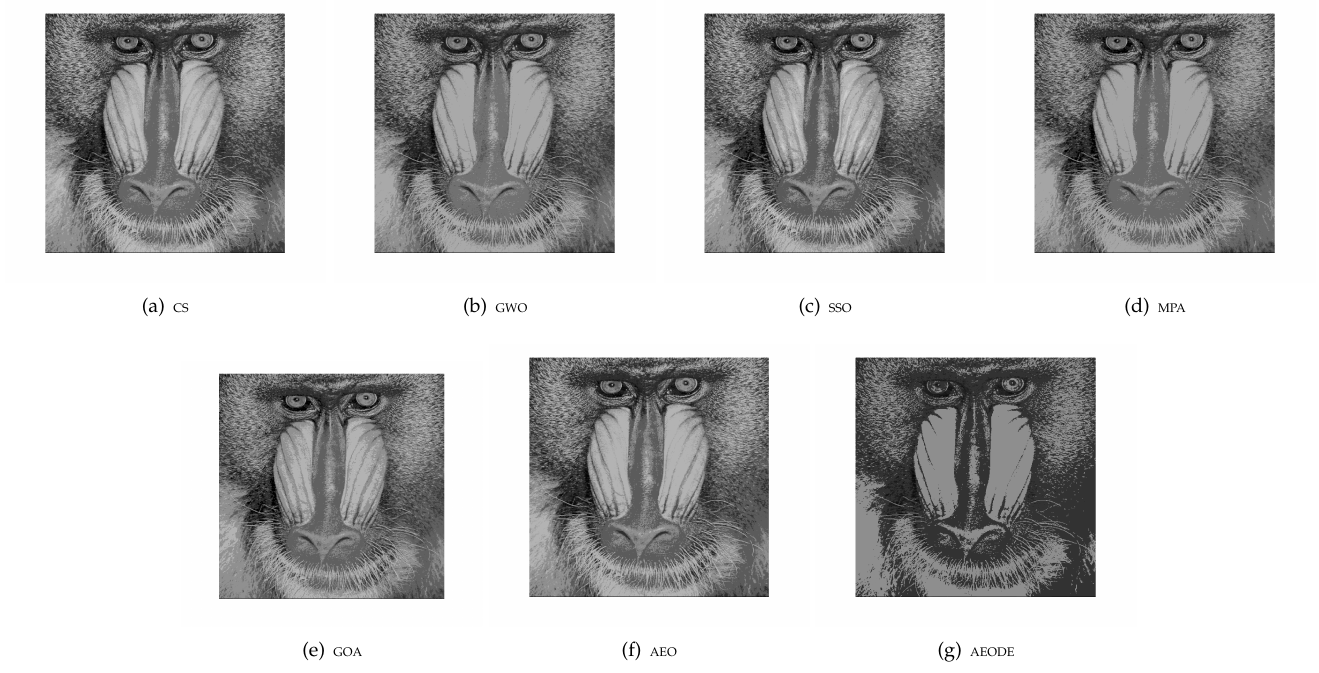
Figure 13. Segmented image I1 at threshold level 19.